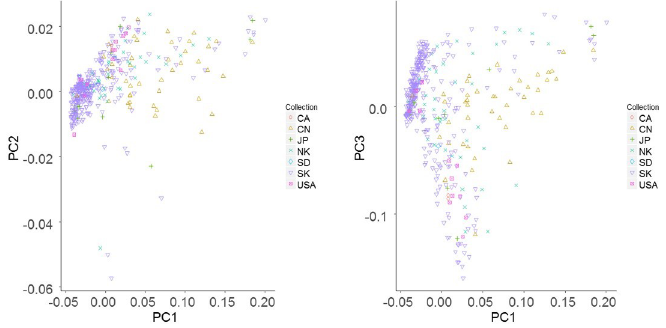
Fig 6. Principal component analysis of the Korean core collection. CA: Canada; CN: China; JP: Japan; NK: North Korea; SD: Sweden; SK: South Korea; USA: United States of America.